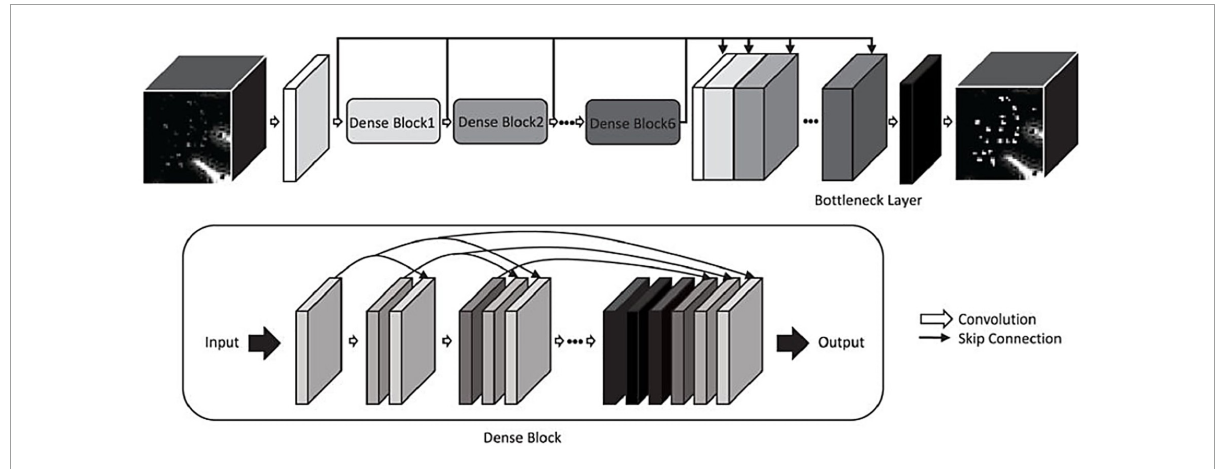
FIGURE5 A convolutional neural network for enhancing PVS visibility in T2-weighted MRI images (Jung et al., 2019). © IEEE 2019.